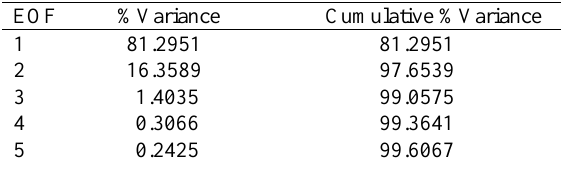
Table 1. Summary of variances at 09:30 LT captured from the DMSP data set by the first five Empirical Orthogonal